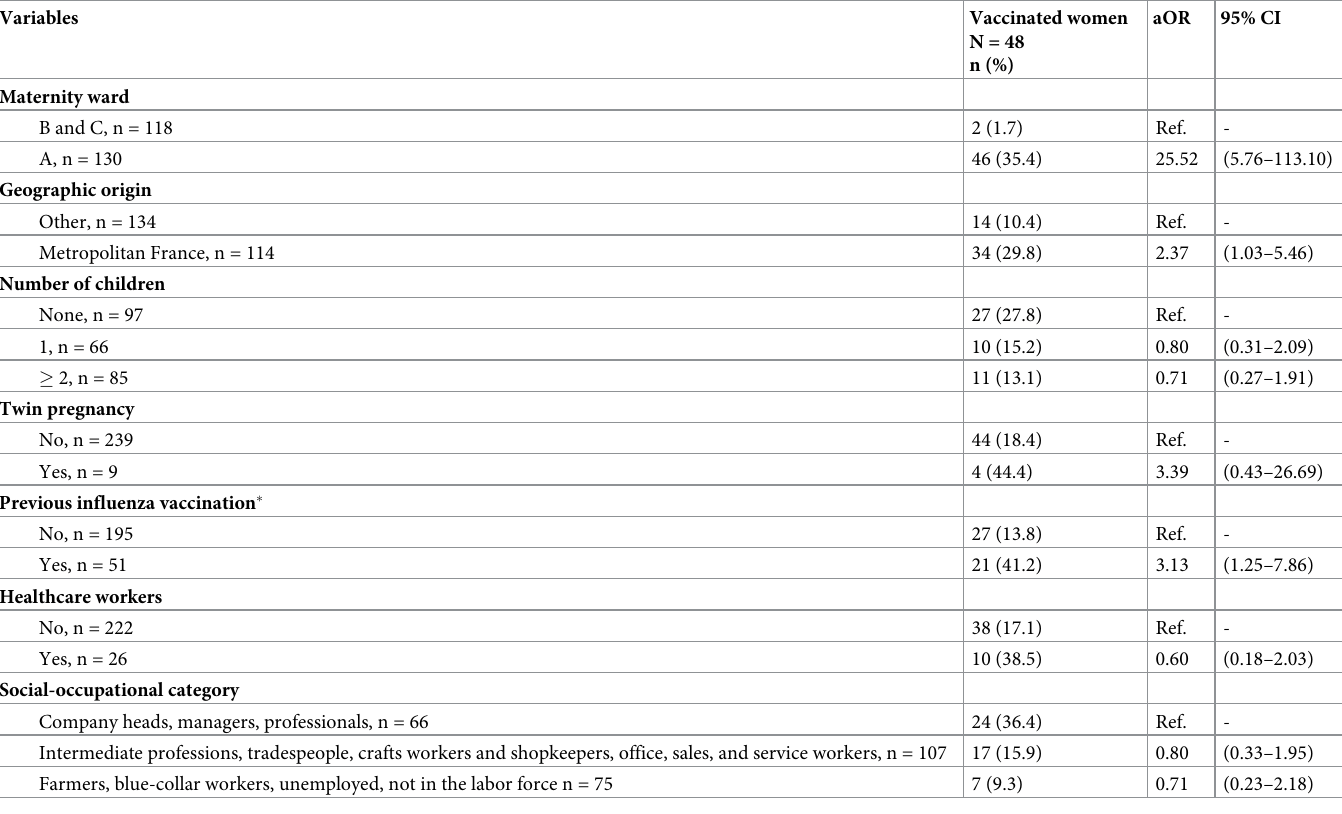
Table 2. Determinants associated with vaccination: Multivariate analysis including maternity ward and social and demographic characteristics (N = 248).